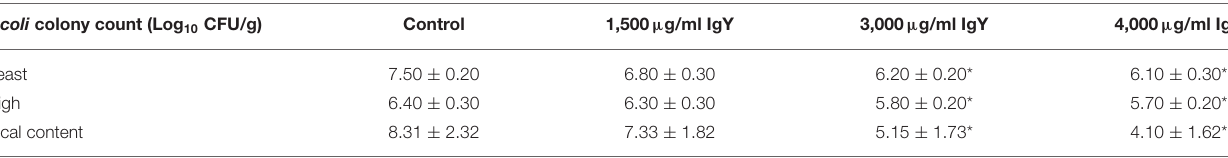
TABLE 7 | Escherichia coli counts in meat muscle and cecal contents. E. coli colony count (Log 10